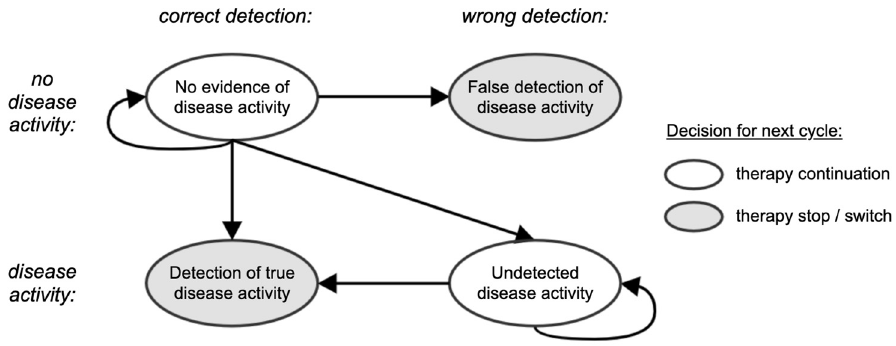
Figure 3. Schematic representation of the clinical decision-making process for a particular decision- making strategy. The disease activity status is either correctly or wrongly detected depending on the available information. At the next cycle, a patient stays on the same therapy if no disease activity is detected or can stop/switch therapy if disease activity is detected.